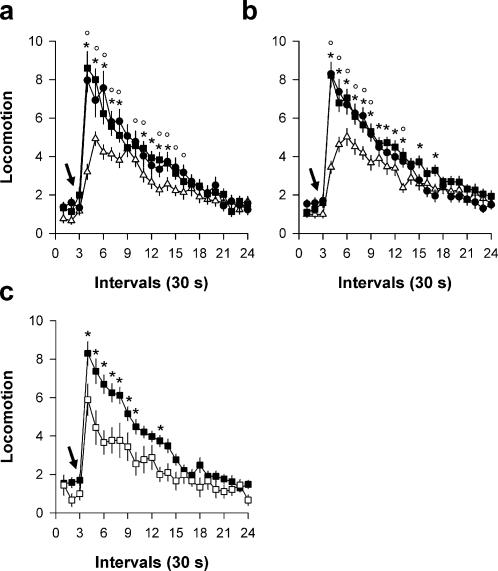
Cocaine-induced locomotion in rats tested under.a, the S-/C+ condition, or b, the S+/C+ condition. Locomotion (i.e., mean number of cage crossings±SEM) was measured during 10 min after the first cocaine self-injection (0.25 mg, i.v.) of the day (open triangle: day 1; closed circle: day 5; closed square: day 15). *, day 5 different from day 1; °, day 15 different from day 1 (P<0.05, Fisher's LSD test). c, Effects of the first cocaine self-injection in rats initially trained under the S+/C- condition and tested for the first time under the S+/C+ condition on day 16. These effects (open square) were compared to the effects of cocaine on day 15 in rats initially trained under the S+/C+ (closed square). *, P<0.05, Fisher's LSD test. The arrow in all graphs indicates the intravenous injection of cocaine.